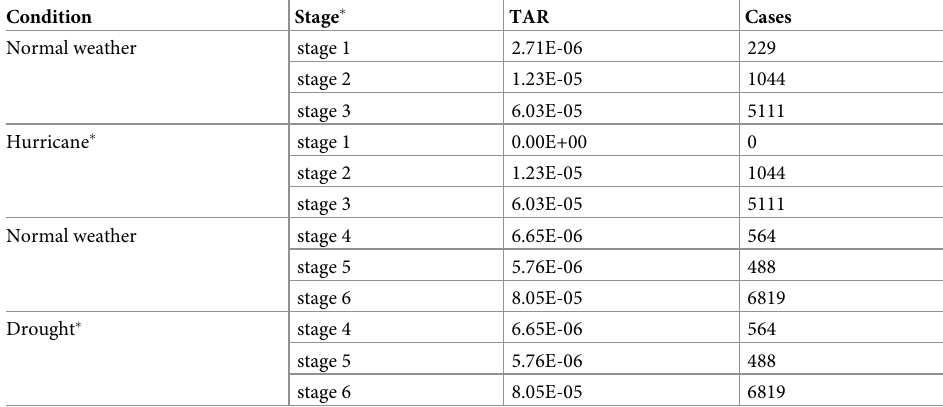
Table 4. Extreme weather forecast in Jiangsu